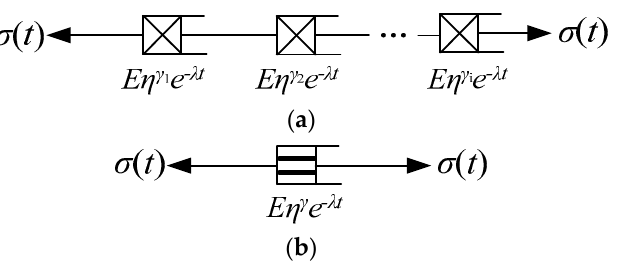
Figure 7. The distributed order damage damper. ( a ) Standard form of the distributed order damage damper, ( b ) The simpli fi ed form.